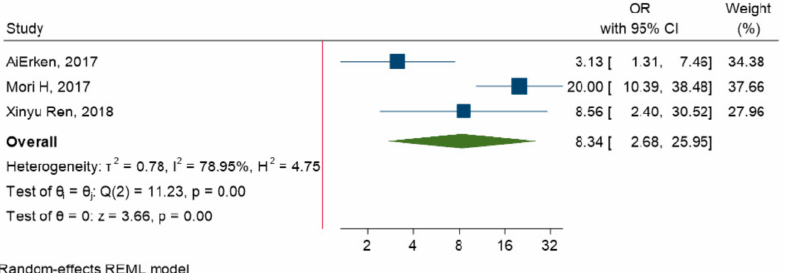
Figure 6. Forest plot of the individual odds ratio for the relation between TILs and PD-L1